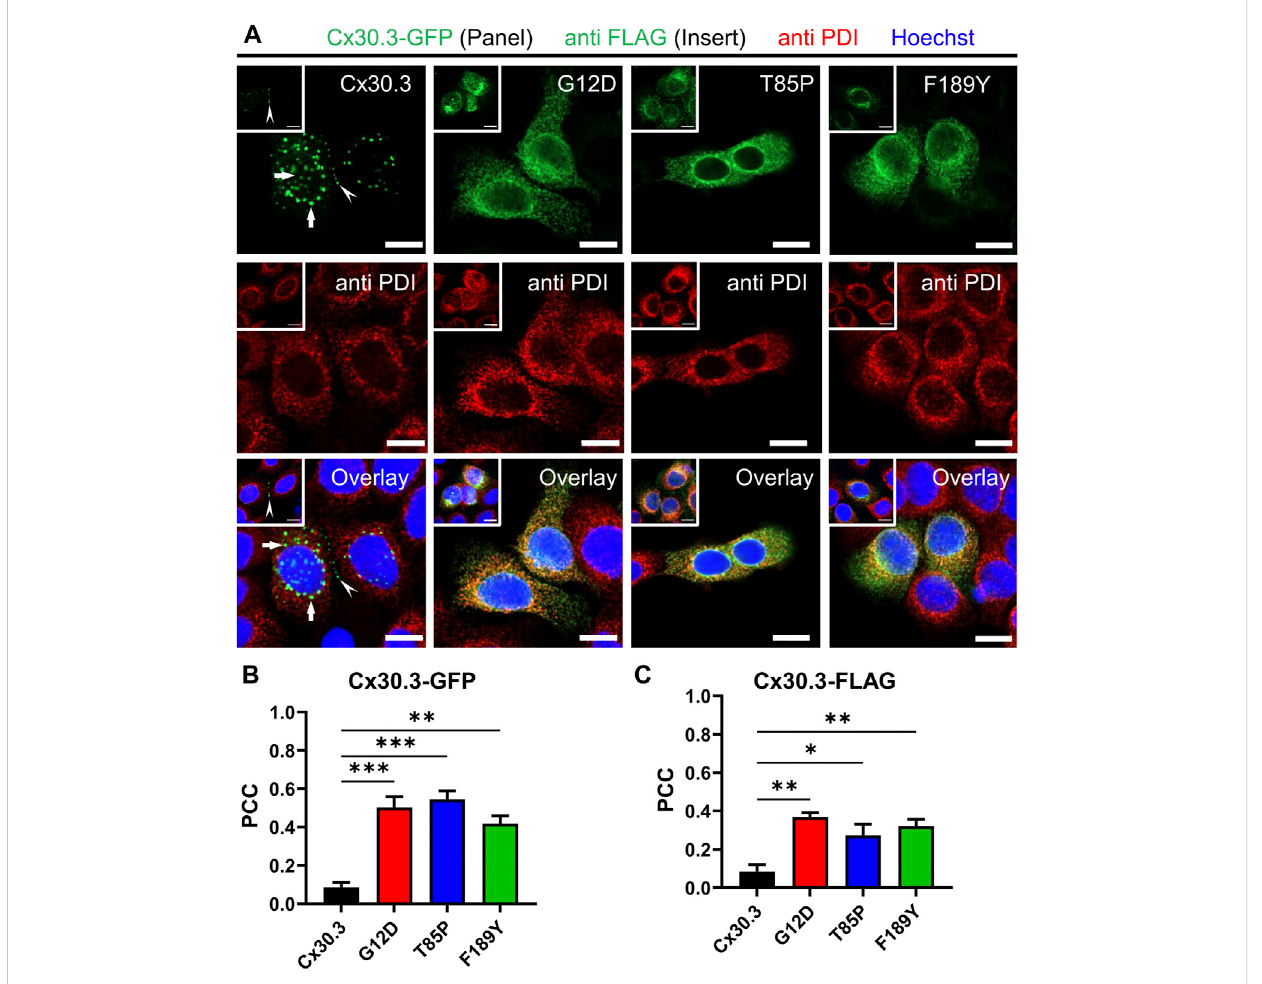
FIGURE 3 Cx30.3mutants arelocalized totheendoplasmic reticulum. (A) GFP-taggedorFLAG-tagged(inserts)Cx30.3(green) traf fi cs andassemblesinto gap junctions (arrowheads). FLAG-tagged Cx30.3 was detected in noticeably fewer intracellular/perinuclear inclusion bodies than GFP-tagged Cx30.3 (arrows).Incontrast,bothGFP-andFLAG-taggedCx30.3mutantsexhibitaprimarilyintracellulardistributionthatcolocalizeswiththeERresidentprotein PDI (red). Nuclei are demarcated by Hoechst 33342 staining (blue). Scale bars = 10 μ m. Quanti fi cation by Pearson ’ s correlation coef fi cient (PCC) indicates that (B) GFP- and (C) FLAG-tagged Cx30.3 mutants signi fi cantly co-localize withPDI ( N = 3for Cx30.3-GFP; N =4 for Cx30.3-FLAG). * p < 0.05; ** p < 0.01; *** p <